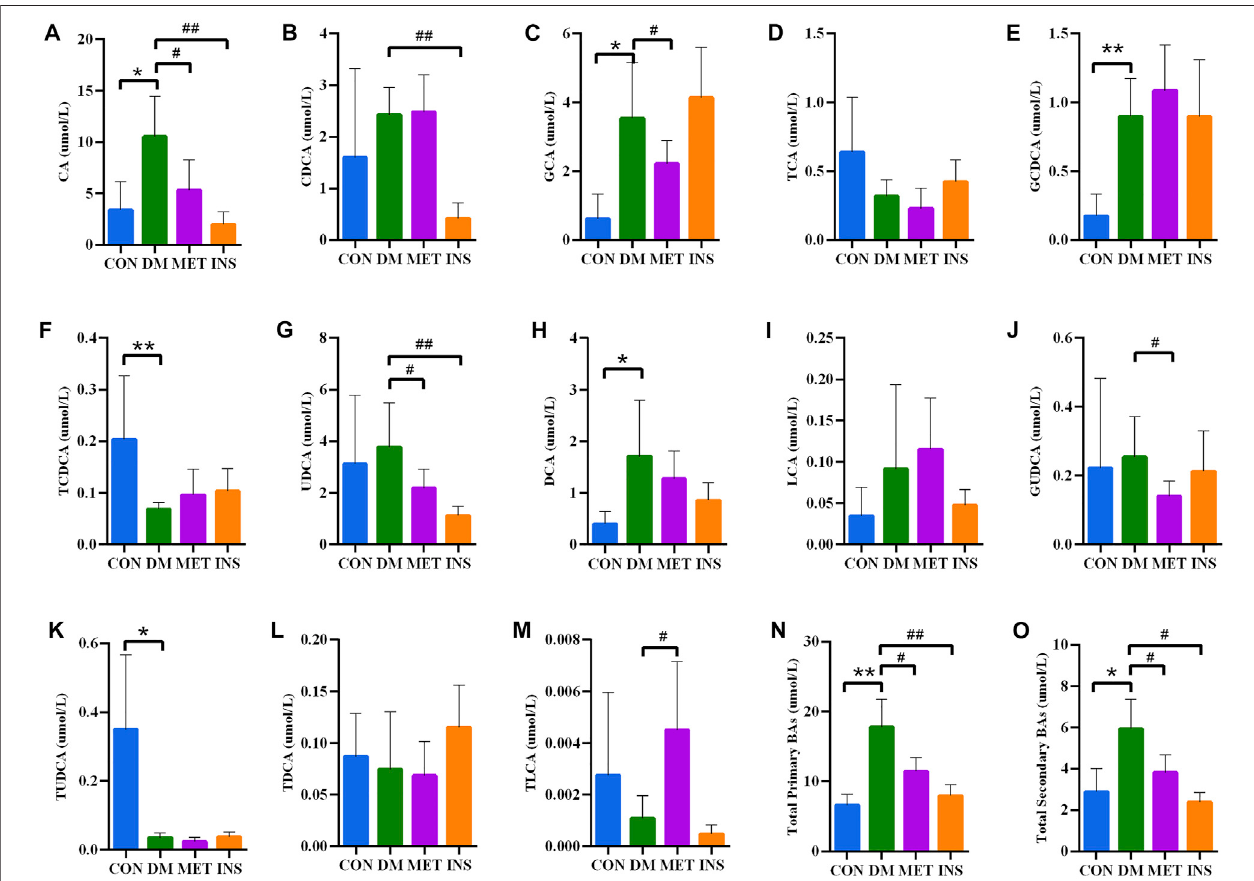
FIGURE5| SerumBAconcentrationsinratsoffourgroups. (A) CA,cholicacid; (B) CDCA,chenodeoxycholicacid; (C) GCA,glycocholicacid; (D) TCA,taurocholic acid; (E) GCDCA, glycochenodeoxycholic acid; (F) TCDCA, taurochenodeoxycholic acid; (G) UDCA, ursodeoxycholic acid; (H) DCA, deoxycholic acid; (I) LCA, lithocholic acid; (J) GUDCA, glycoursodeoxycholic acid; (K) TUDCA, Tauroursodeoxycholic acid; (L) TDCA, taurodeoxycholic acid; (M) TLCA, taurolithocholic acid; (N) Total primary BAs; (O) Total secondary BAs. * p < 0.05, ** p < 0.01 vs. CON group. # p < 0.05, ## p < 0.01 vs. DM group.